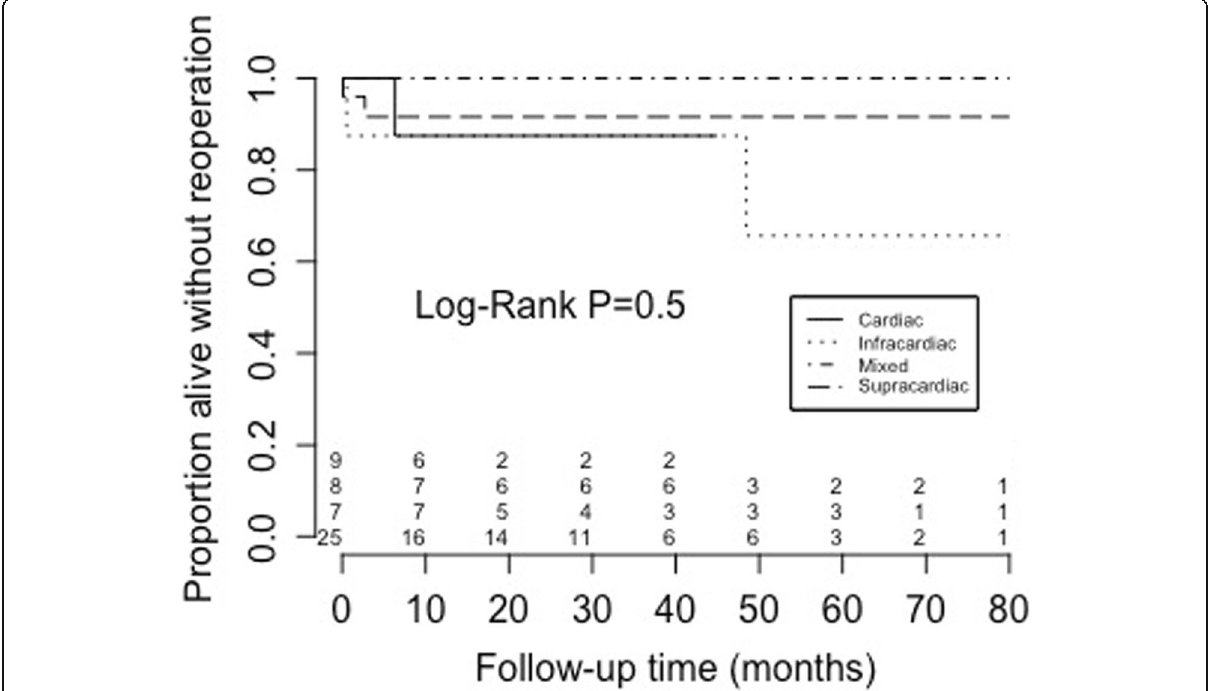
Fig. 2 Kaplan-Meier freedom from death or reoperation shown by TAPVD anatomical types